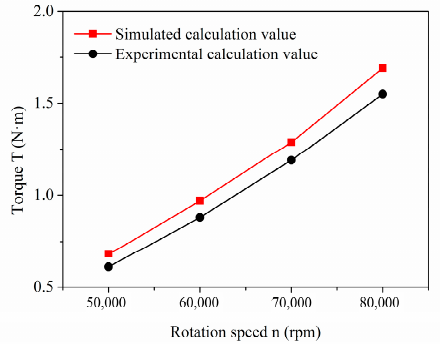
Table 4. Test results of air compressor motor.